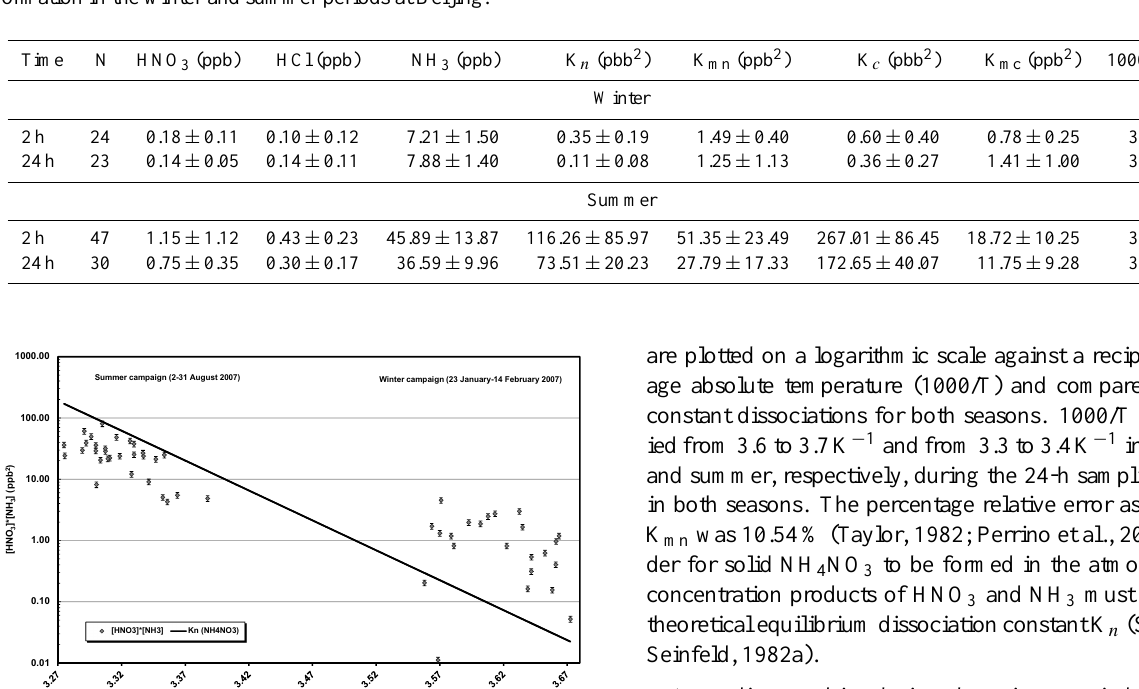
Table 3. Mean values ± standard deviation of some components, such as theoretical equilibrium constant (K n ) and measured concentration product (K mn ) of NH 4 NO 3 formation and theoretical equilibrium constant (K c ) and measured concentration product (K mc ) of NH 4 Cl formation in the winter and summer periods at Beijing.